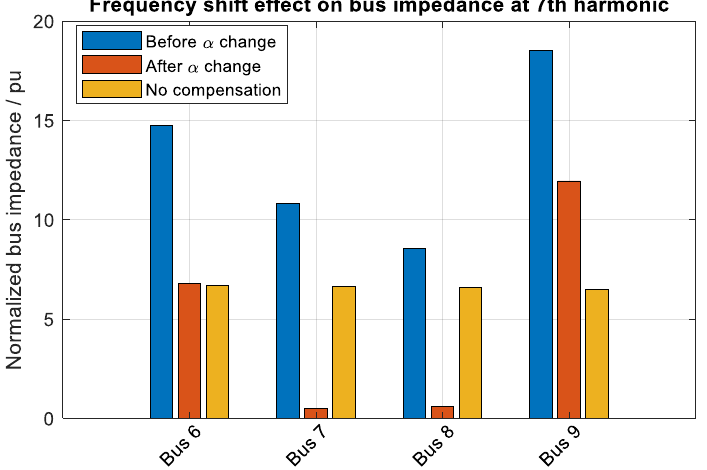
Figure 17. Comparison of the impedances of busses 6, 7, 8 and 9 before and after the series frequency shift.